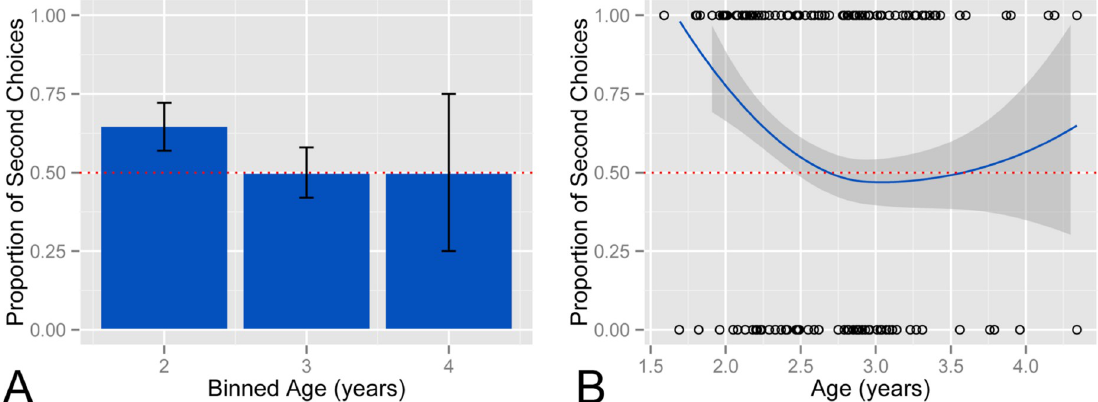
Fig 3. Recency bias present in natural parent-child setting. (A) Proportion of second-choice responses in CHILDES binned by age of the children in years. (B) A smoothed LOESS curve fitted to the raw data from CHILDES (empty dots).